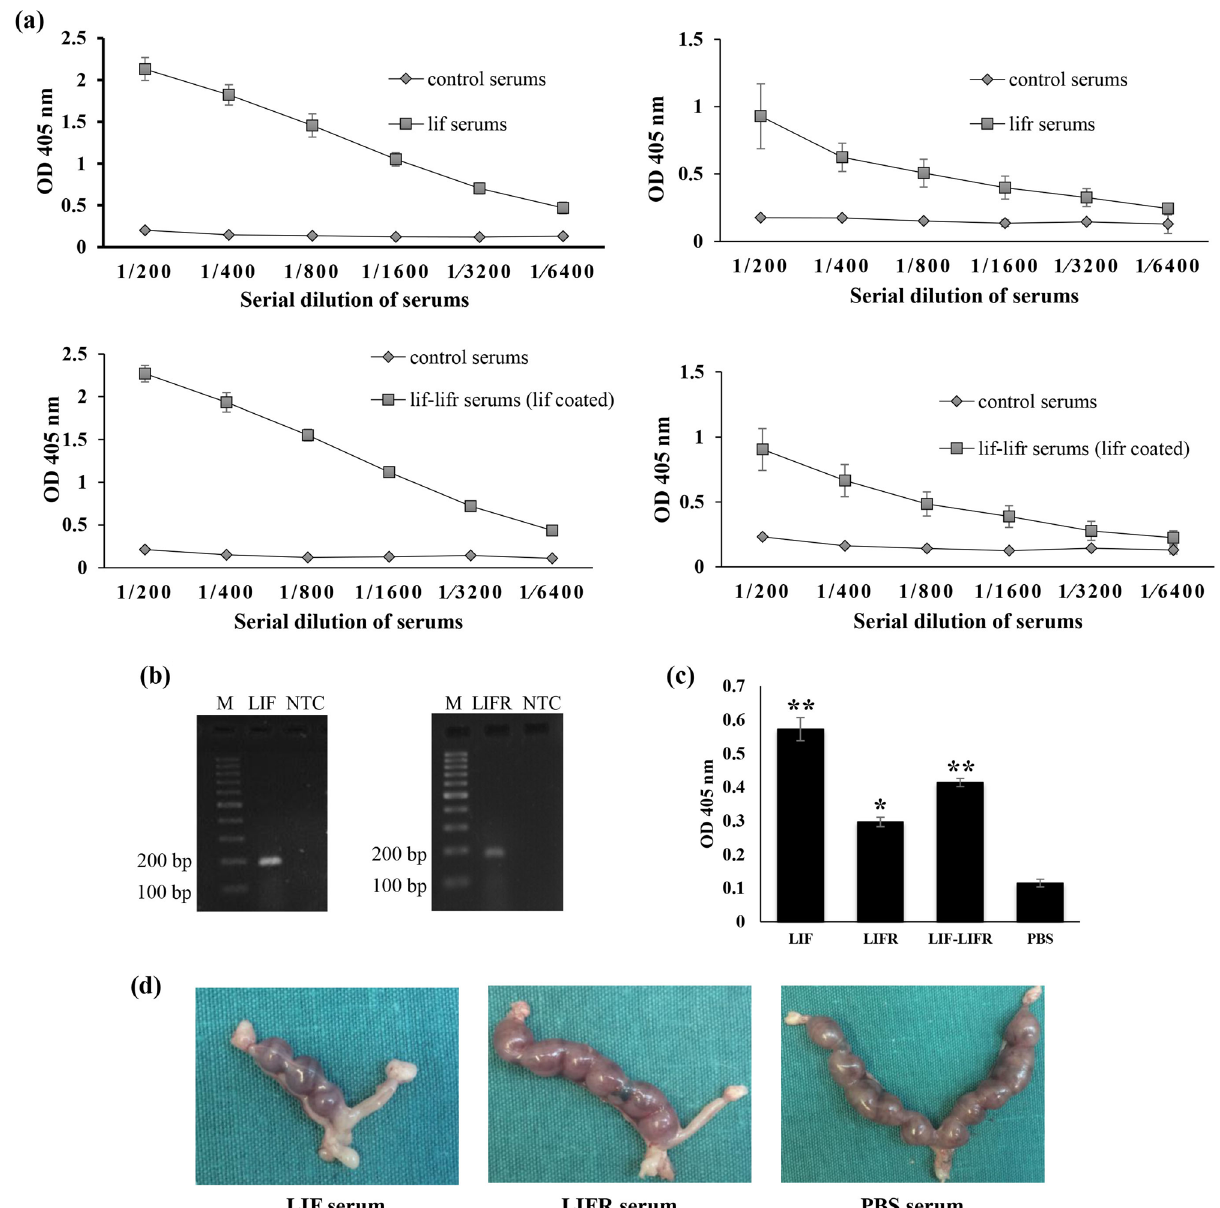
Figure 3. Titration and functional assay of LIF and LIFR antibodies. ( a ) Serially diluted antiserums recognized the rtLIF and rtLIFR proteins coated in ELISA plates. ( b ) RT-PCR revealed the expression of both LIF (184 bp) and LIFR (167 bp) by the MC4-L2 puro cells ( c ) LIF and LIFR serums reacted with LIF and LIFR proteins derived from MC4-L2 puro cells. Data represent mean ± SD of three independent experiments, * p < 0.01, ** p < 0.001. ( d ) Neutralization assay showed intrauterine injection of LIF or LIFR antiserums in one horn blocked uterus implantation of embryos. The other horn was left noninjected for pregnancy